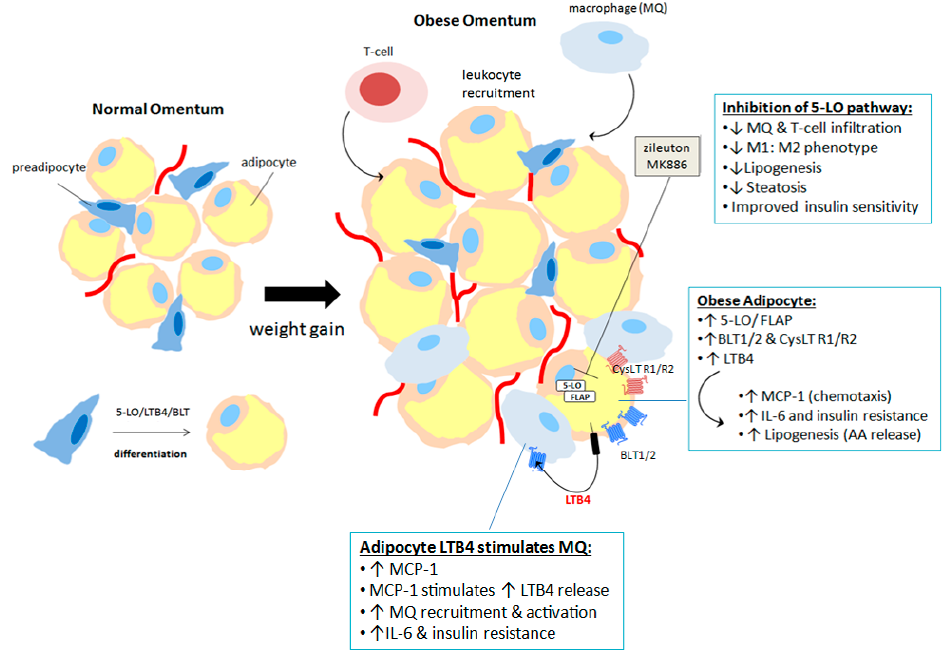
Figure 5. Increased 5-lipoxygenase activity in adipose tissue is associated with obesity: 5-LO signalling has been shown to be involved in preadipocyte differentiation to mature an adipocyte. Adipocytes derived from obese adipose tissue have increased 5-LO/FLAP expression and increased leukotriene receptor expression. Upregulated LTB4 production leads to increased MCP-1 production and increased macrophage (MQ) and T-cell recruitment to the fat. Increased LTB4 signalling also leads to upregulated lipogenesis and thus increased arachidonic acid (AA) availability for further leukotriene synthesis by adipocytes and adipose tissue associated MQs (ATM). LTB4 stimulates MQ production of MCP-1, further LTB4 production, increased pro-inflammatory cytokines such as IL-6 and increased macrophage homing to the fat. Pharmacological blocking of 5-LO signalling in adipose tissue decreases lipogenesis, leukocyte infiltration, decreases M1 type MQs and increases M2 type MQs, overall leading to improved insulin sensitivity and liver